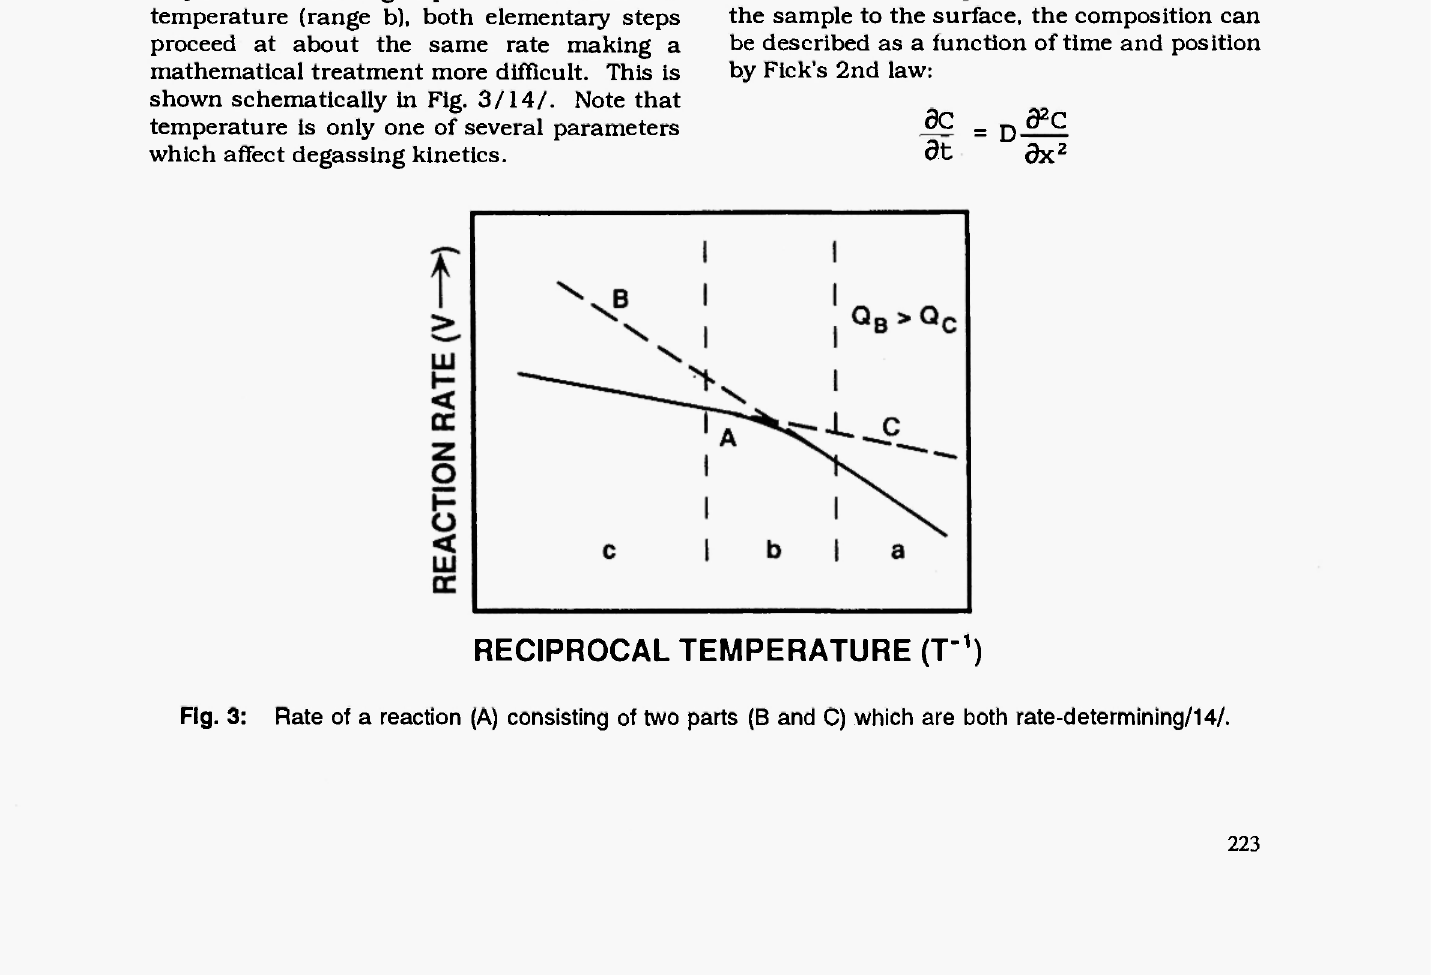
Fig. 2: Energy diagram of the degassing of metal-gas solid soolutions of degassing type. For keys see Table 2/14/.